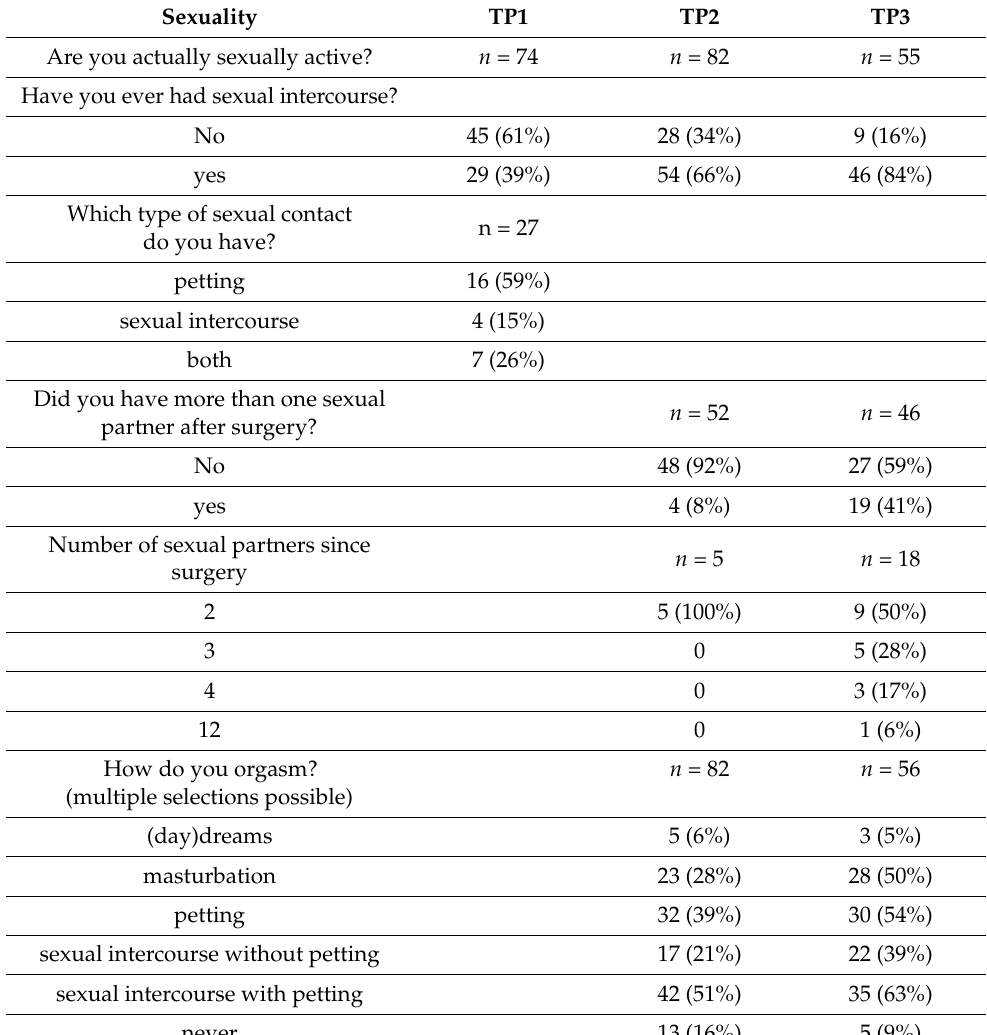
Table 3. Sexual contacts, sexual partners, sexual intercourse (different patient numbers show different rates of completed